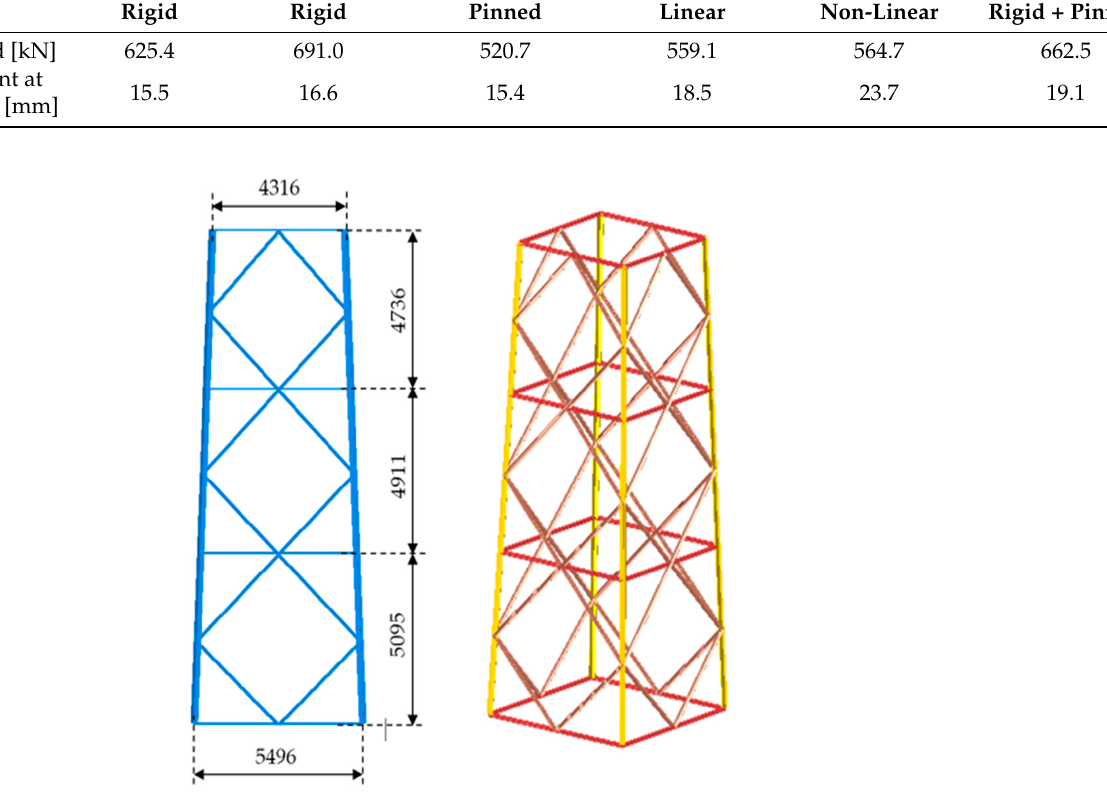
Figure 13. 3D- subassembly dimensions and geometry. On the right-side picture: in pink, the L60x5 section braces; in yellow, the L152x11 main legs; and in red, the 100x5 braces.